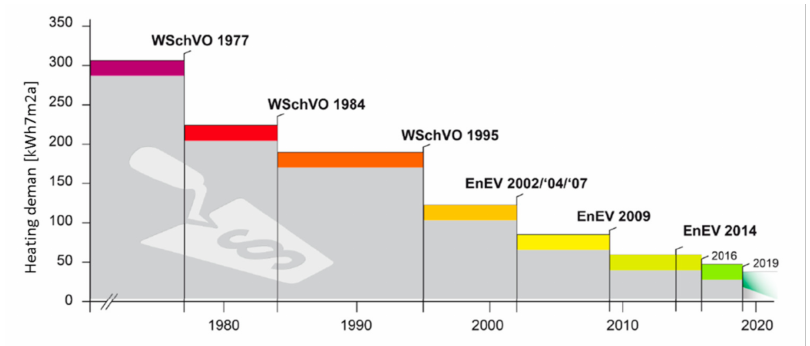
Figure A1. EnEV standards according to [29].